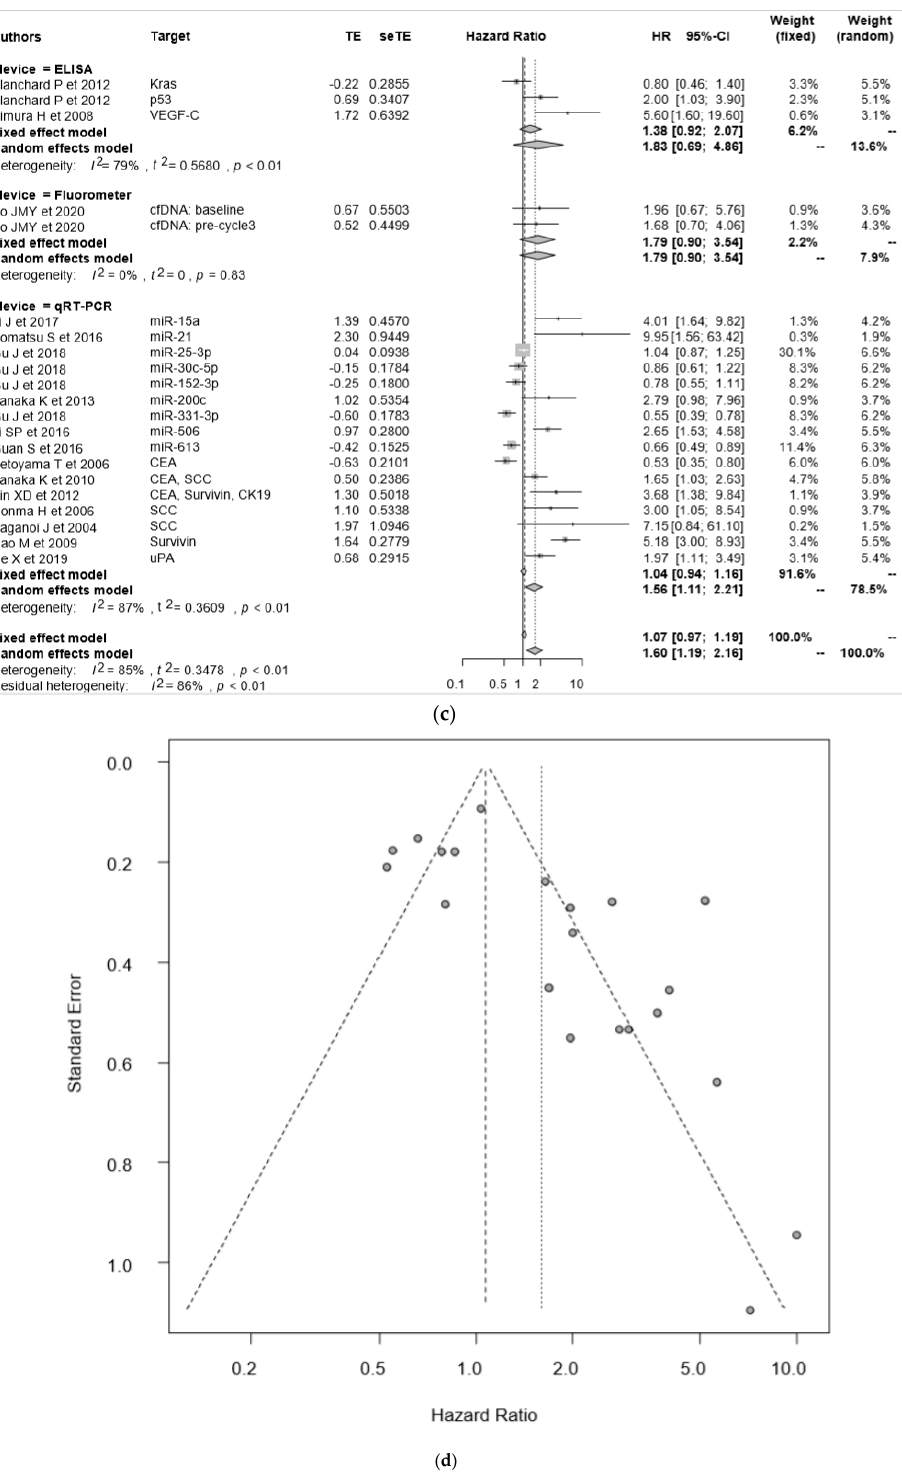
Figure 3. The progression free survival (FS) analysis of liquid biopsies. ( a ) Forest plot of the hazard ratio for PFS in the cytometric assay; ( b ) funnel plot for the publication bias of ( a ); ( c ) forest plot of the hazard ratio for PFS in the non-cytometric assays; ( d ) funnel plot for the publication bias of ( c ).